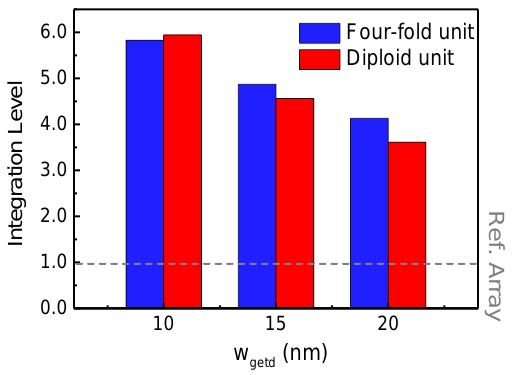
Figure 17. Integration density rates of vertical PCM arrays with diploid and four-fold units compared to the conventional vertical PCM array in [22] as functions of 𝑤 getd . Table 3. Comparison between proposed PCM cells and the cell discussed in [22].